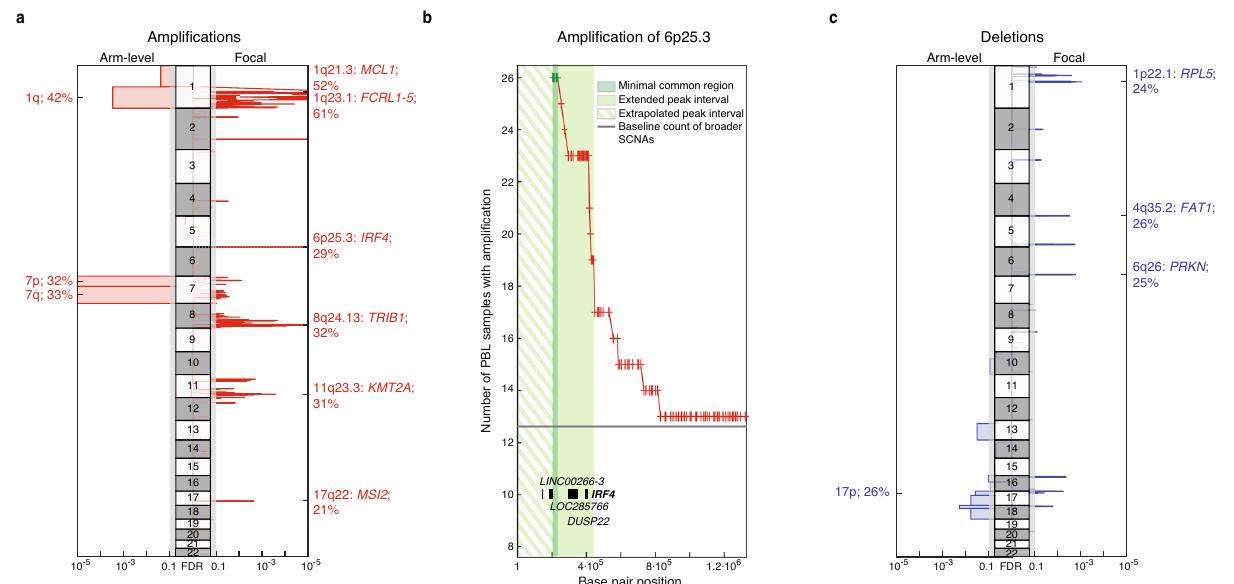
Fig. 2 Somatic copy number alterations in primary PBL cases. GISTIC v2.0.23 de fi ned copy number a ampli fi cations (red) are visualized for each chromosome, arm-level alterations on the left, and focal lesions on the right. Insigni fi cant lesions ( q G2.0 > 0.1) are shaded in gray. Selected potential driver genes within signi fi cant focal lesions are highlighted with corresponding cohort frequencies. b Pileup plot depicting the number of primary PBL samples with copy number ampli fi cations at the beginning of chromosome 6 (cytoband 6p25.3). The minimal common region (MCR) determined by GISTIC and the robustly extended peak region is highlighted in green. Contained genes are labeled. The MCR starts with the fi rst available SNP probe (marked by red crosses) on the chromosomal arm while only noncoding genes LOC285766 and LINC00266-3 are located left in the extrapolated extended peak region (striped). c Copy number deletions (blue) are correspondingly shown for each chromosome. See Supplementary Data 7 and 8 for all